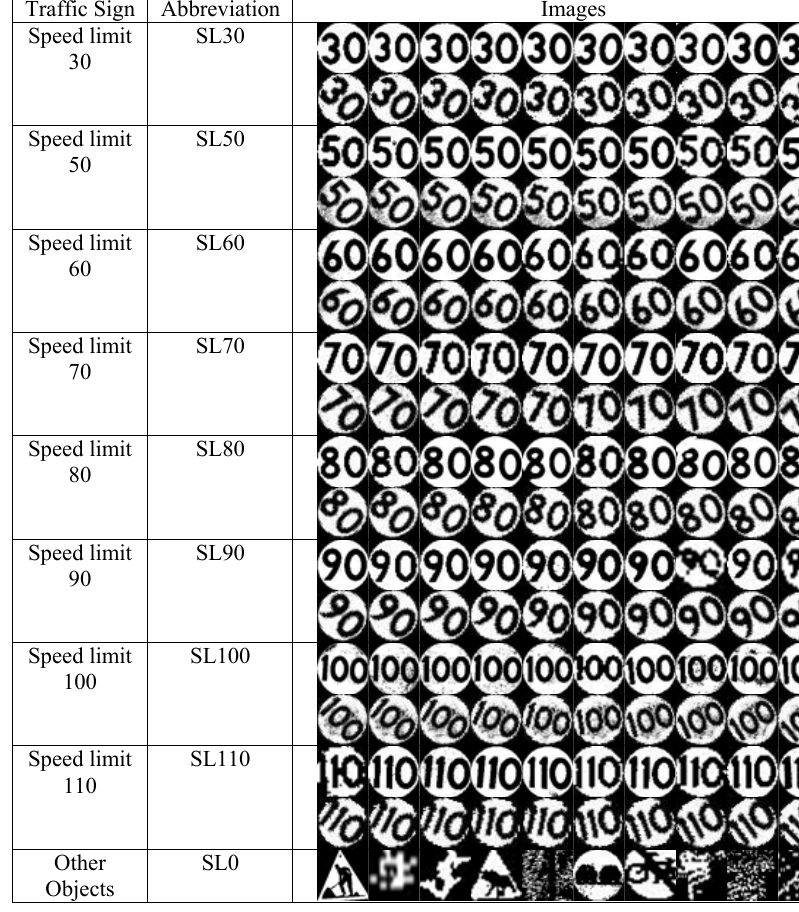
Table 1. Part of the image database of the speed limit